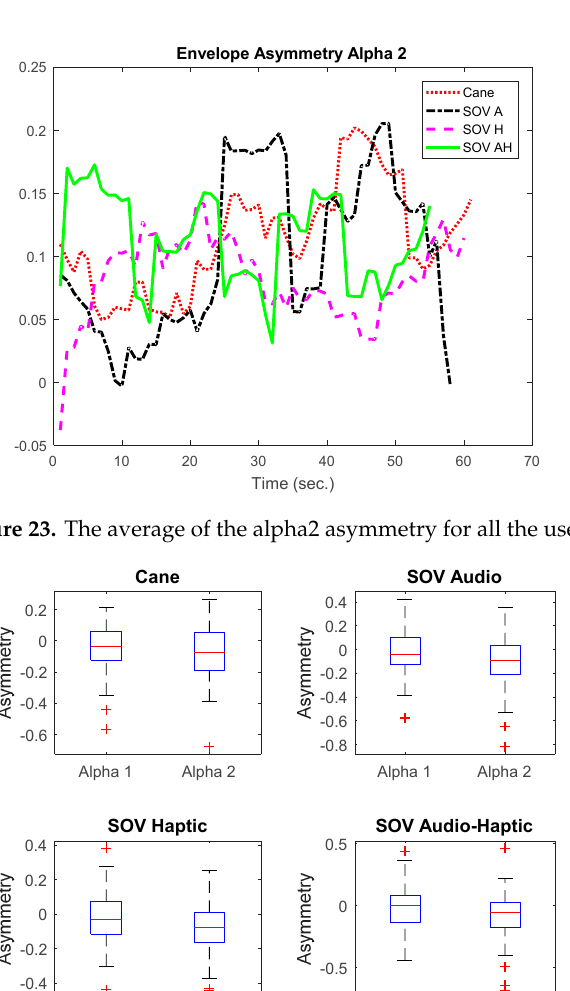
Figure 24. The envelopes for all the users, for scenario E. Sensors 2020 , 20 , x FOR PEER REVIEW